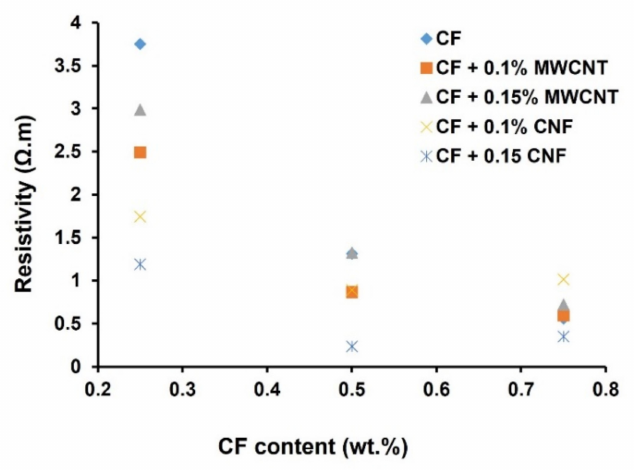
Figure 8. Influence of CF, CNF and MWCNT on the electrical resistance of cementitious